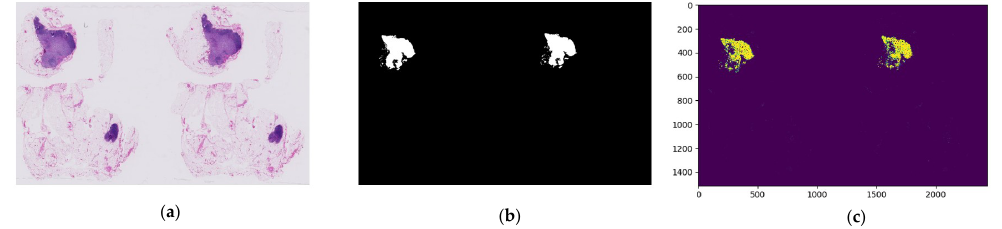
Figure 6. Predicted probability map for Test_071 by our approach. ( a ) original image test_071. ( b ) ground truth annotation. ( c ) predicted probability